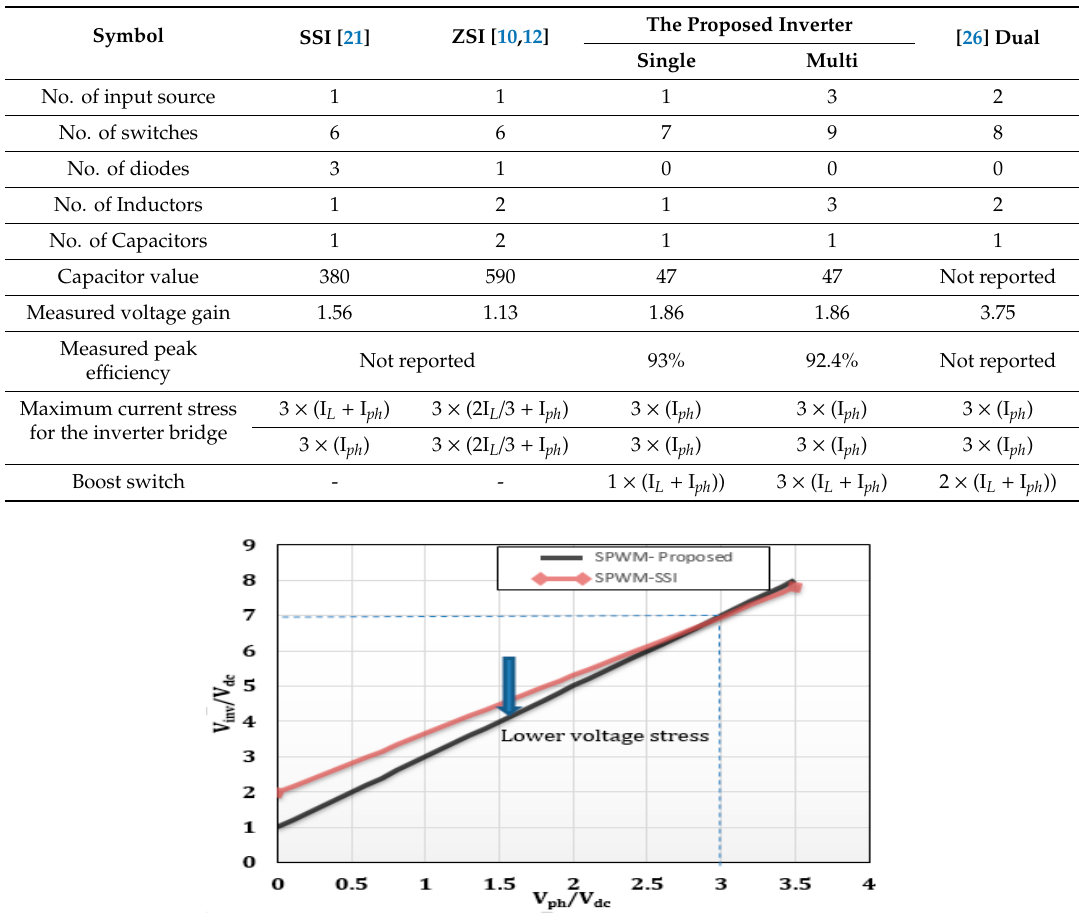
Figure 19. The conversion ratio V inv /V dc versus V ph /V dc for both Split Source Inverter (SSI) topology and the proposed inverter.